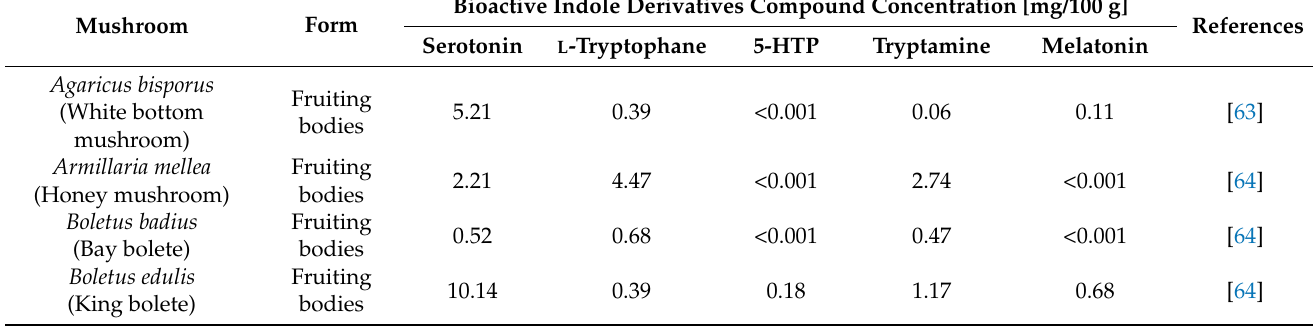
Table 1. Bioactive indole compounds found in selected 15 genera of edible mushrooms. NA— not